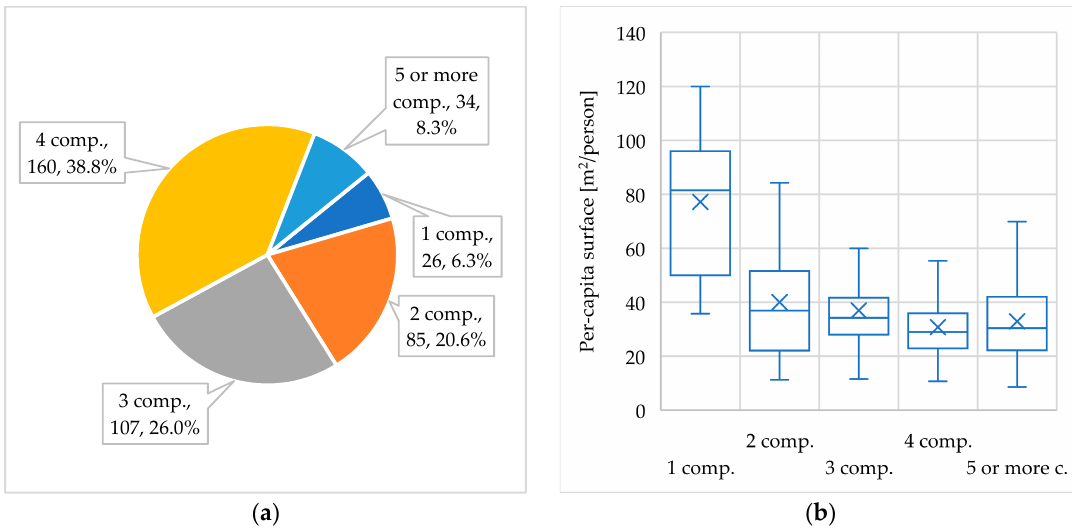
Figure 3. Buildings' subdivision. ( a ) Household vs. family components; ( b ) Per-capita surface vs. family components.